Question: What kind of plot is shown here?
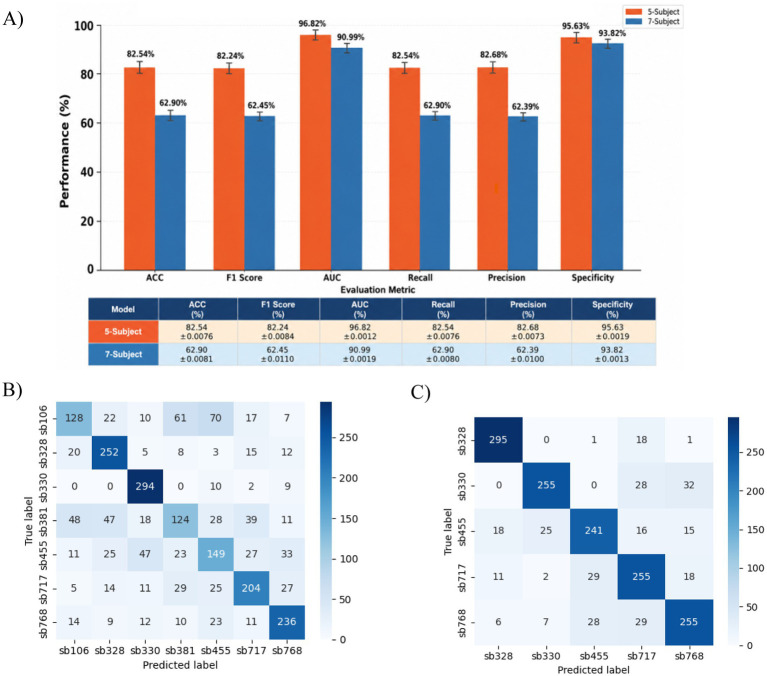
Answer: heatmap